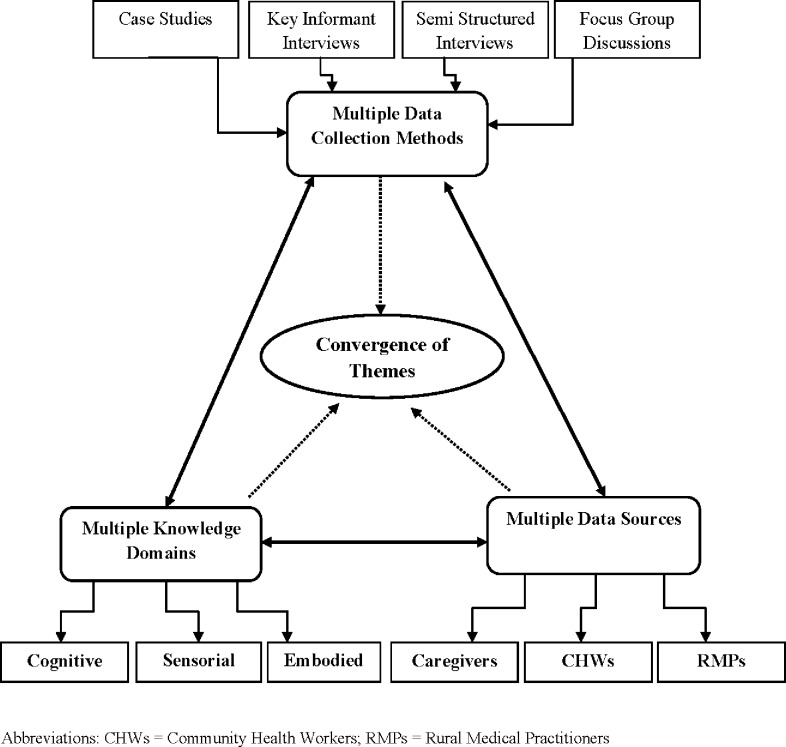
Triangulation Plan.